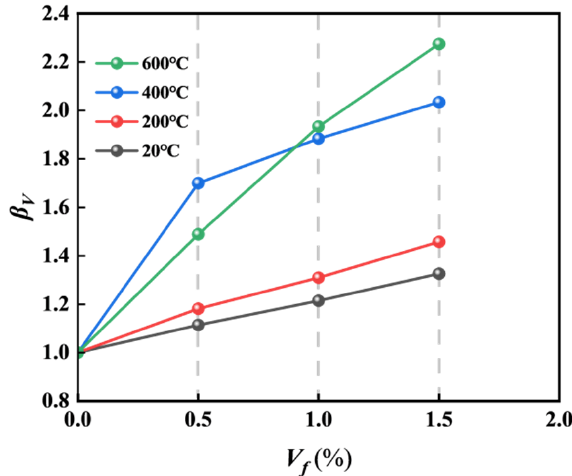
Figure 11. β V – V f curves.